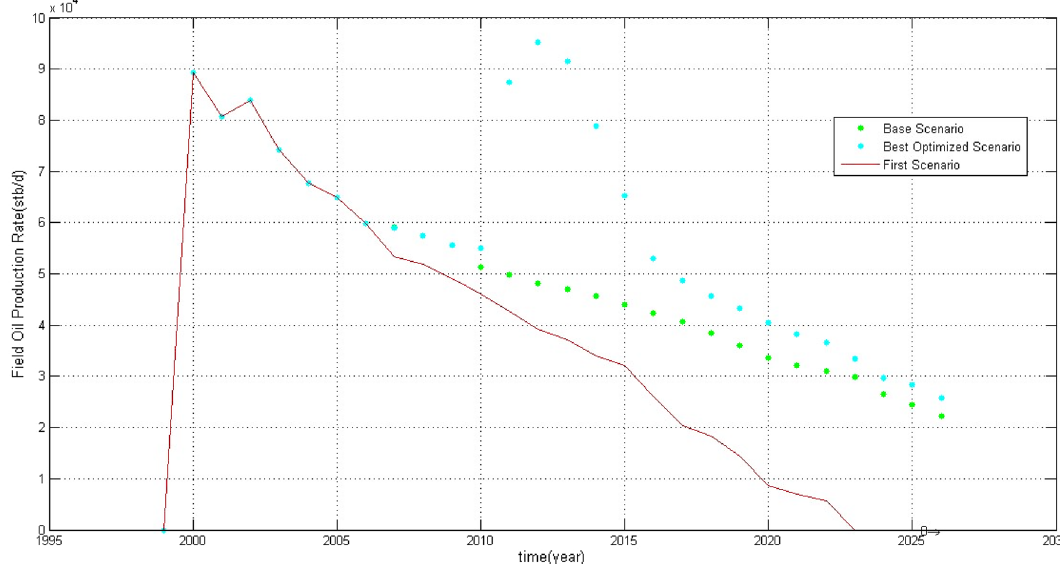
Fig. 3 Field production rate of first